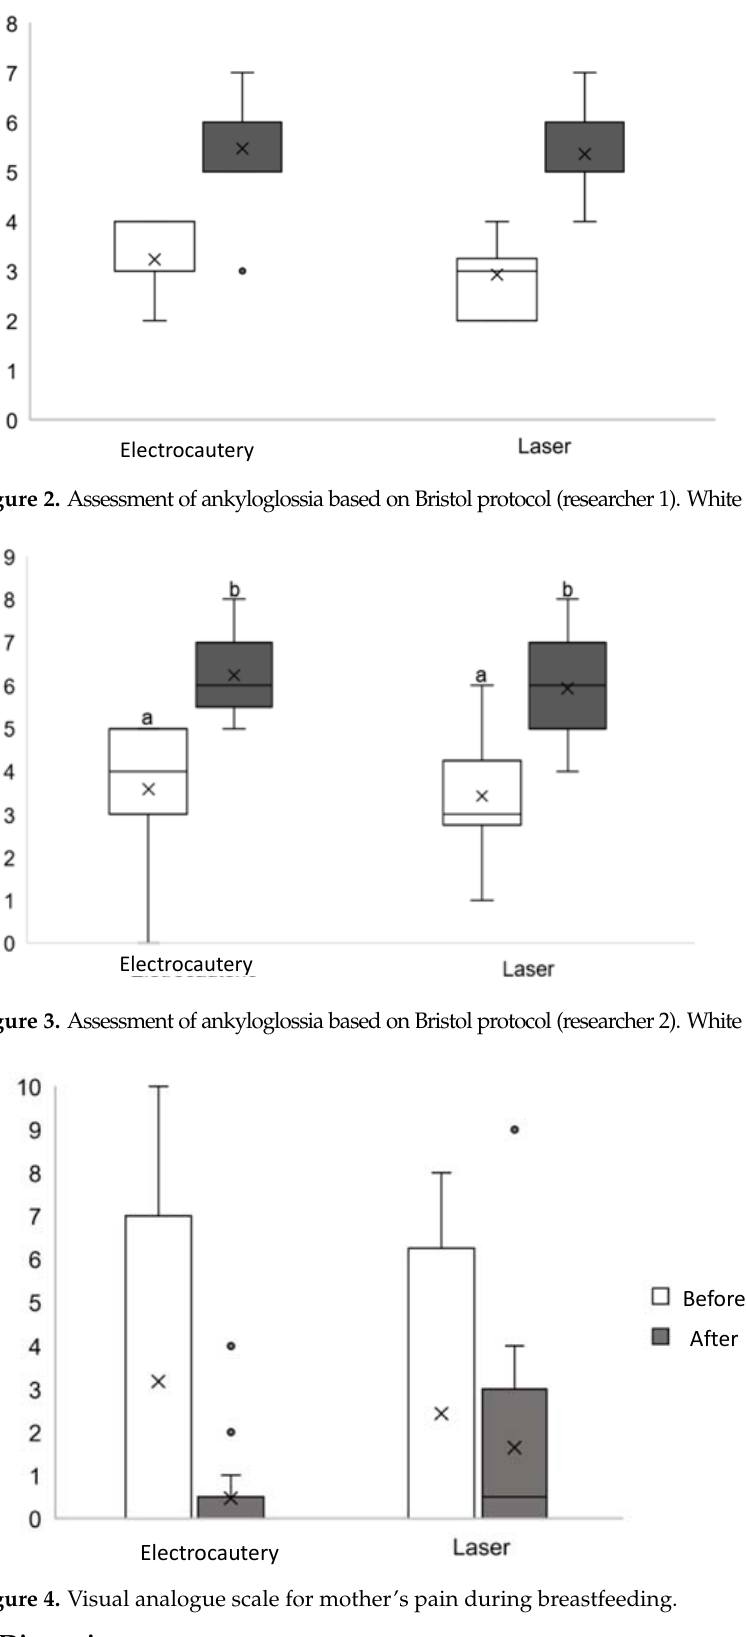
Figure 4. Visual analogue scale for mother’s pain during breastfeeding .